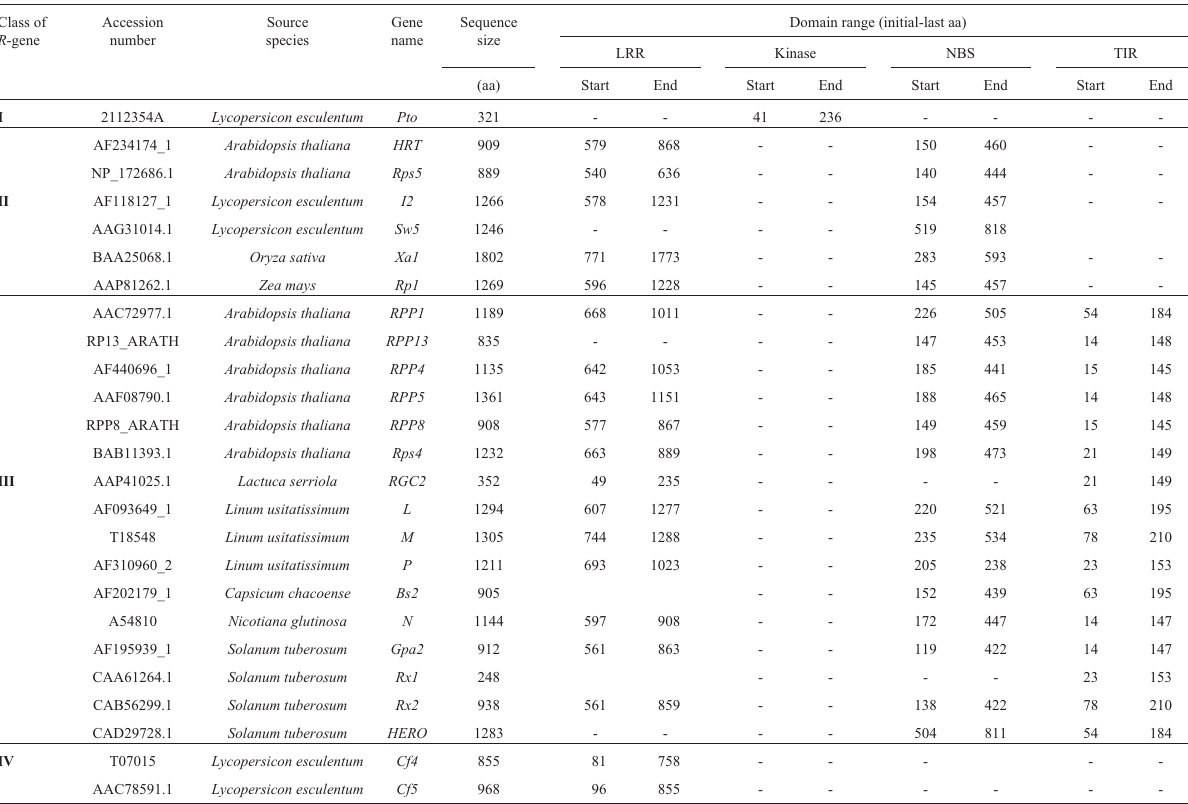
Table 1 - Classification and features of R -genes used as query against the FOREST database. The used genes are grouped in five R -gene classes ( I : Kinase; II :LRR+NBS; III :LRR+NBS+TIR; IV :onlyLRR; V :LRR+Kinase)withrespectiveaccessionnumberatNCBI,sourcespecies,genenameand domain range (in